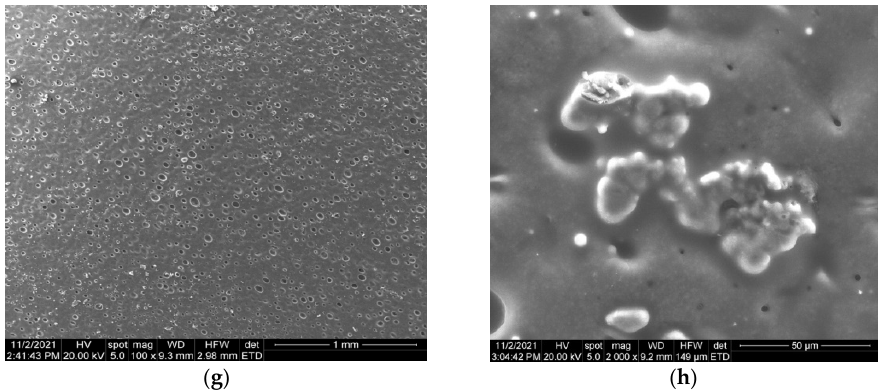
Figure 6. SEM micrographs showing the morphology of the films: CC ( a , b ), CC@MWCNT_TiO 2 0.01 ( c , d ), CC@MWCNT_TiO 2 0.025 ( e , f ) and CC@MWCNT_TiO 2 0.05 ( g , h ).